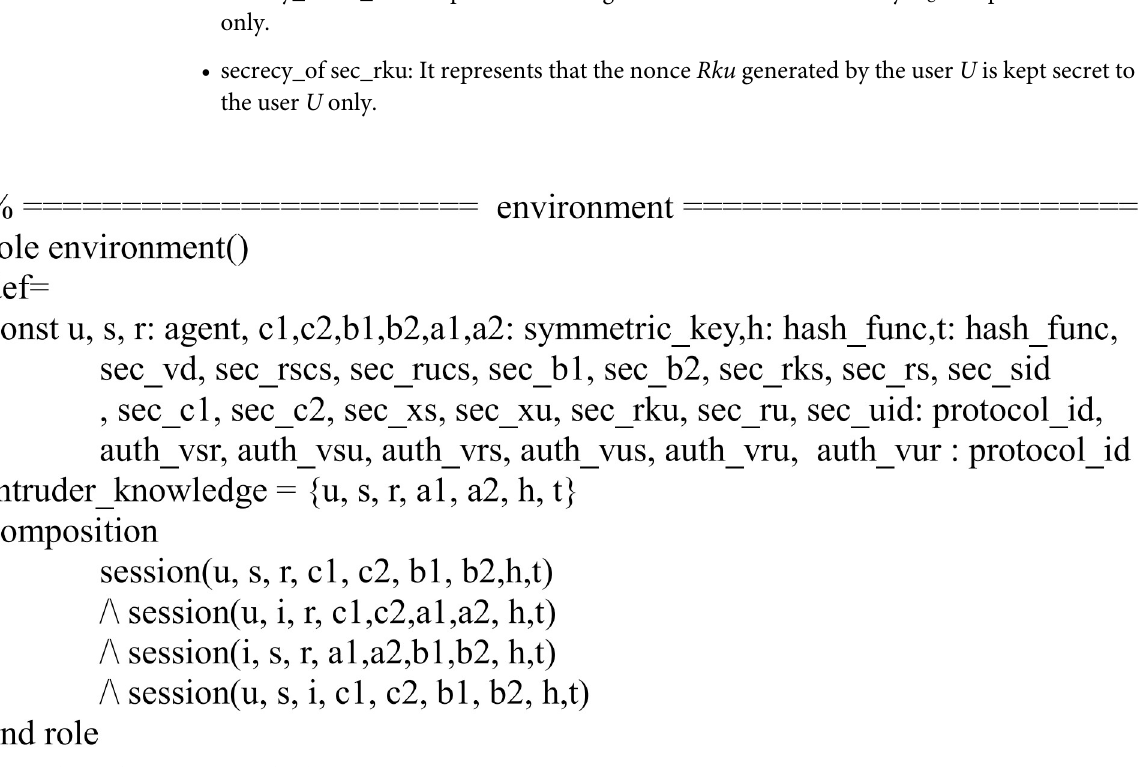
Fig 8. Role specification in HLPSL for the